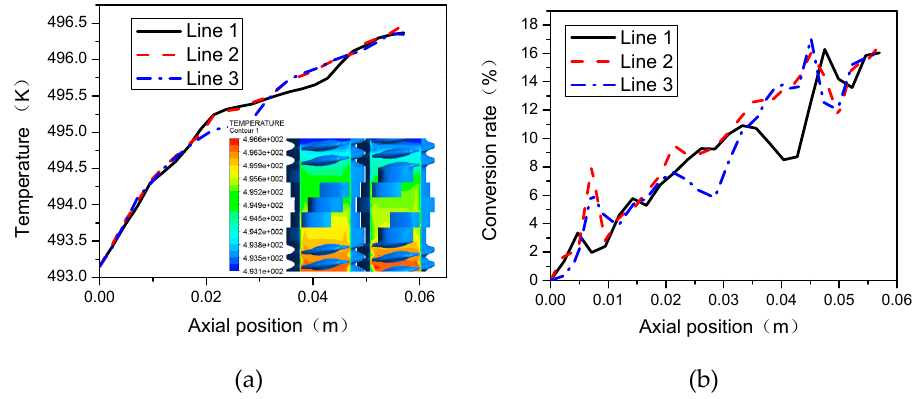
Figure 9. Profiles of temperature and conversion at different monitor lines: ( a ) temperature; ( b ) local conversion